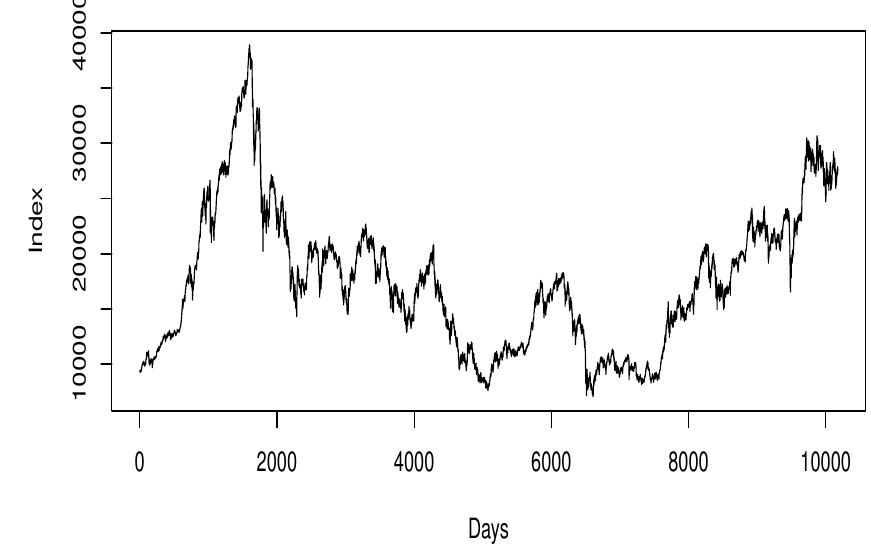
Figure 3. The daily return for the stock